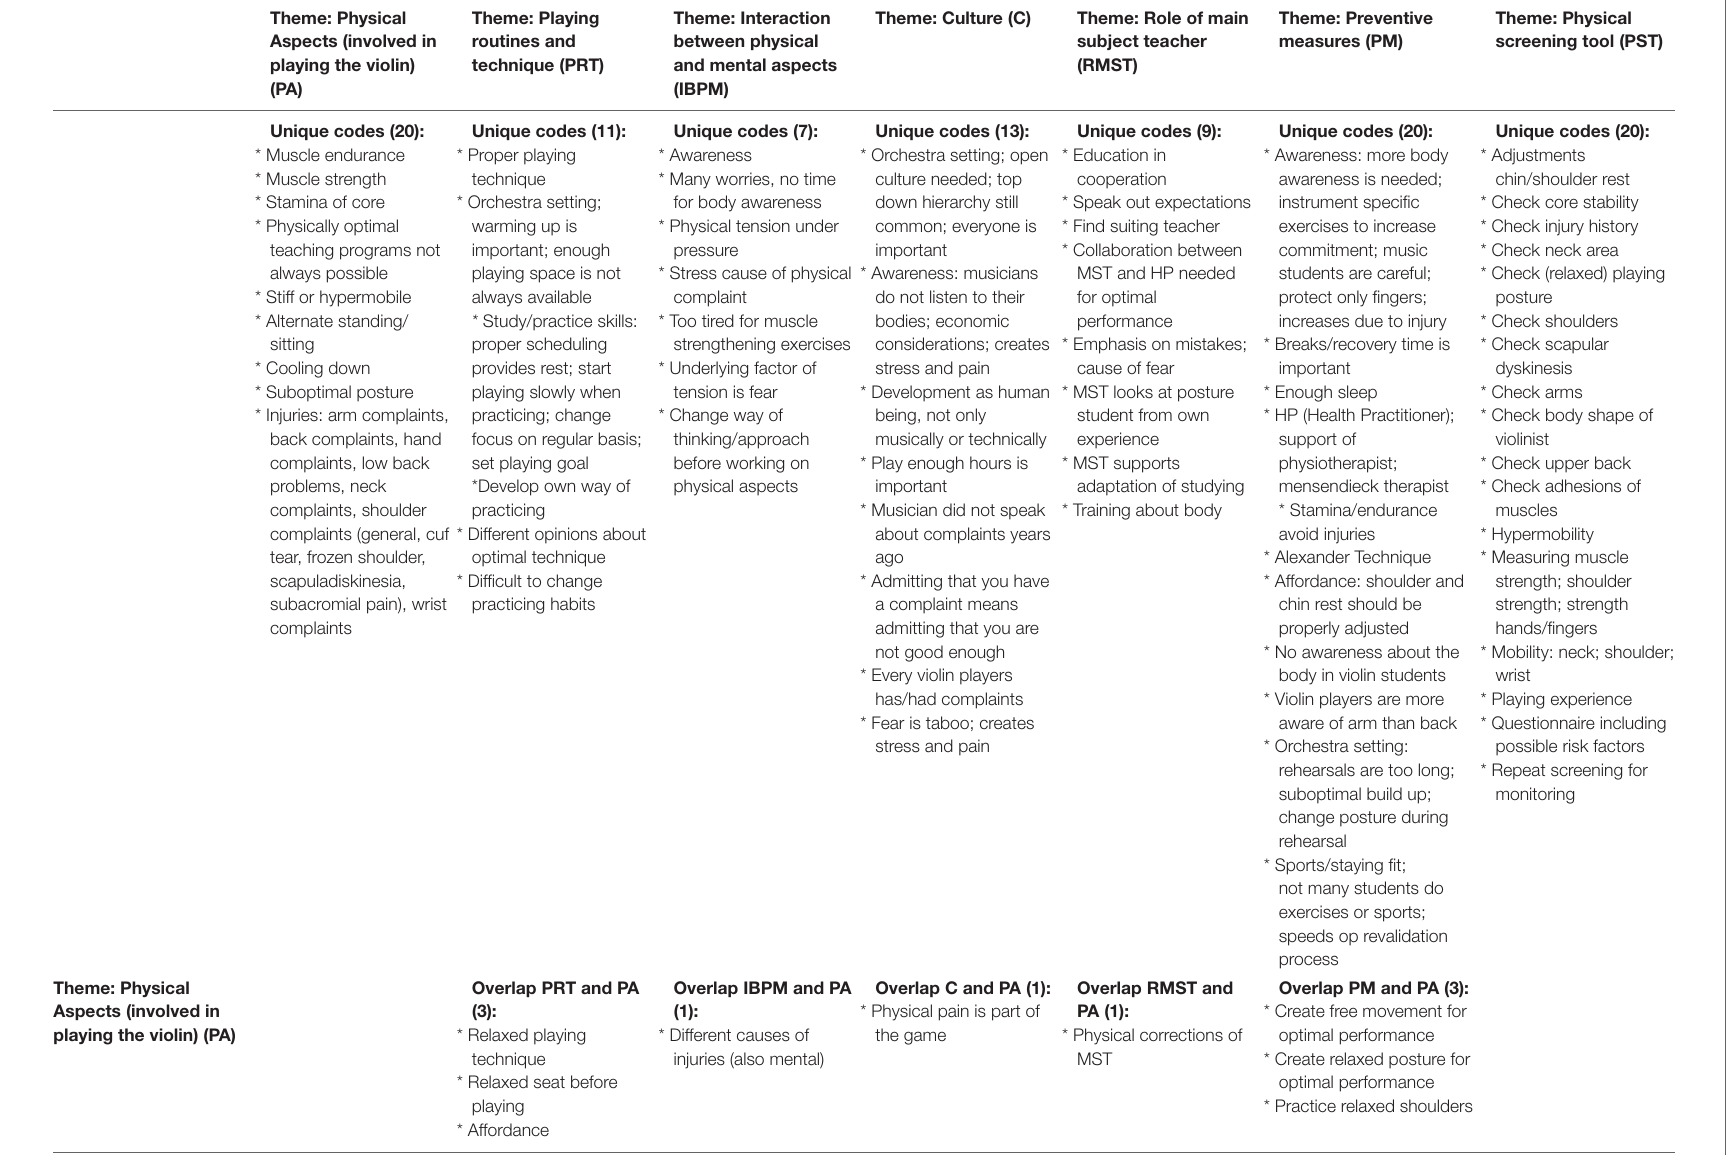
TABLE 2 | Themes and codes, each theme represents a cluster of codes and some codes contribute to more than one